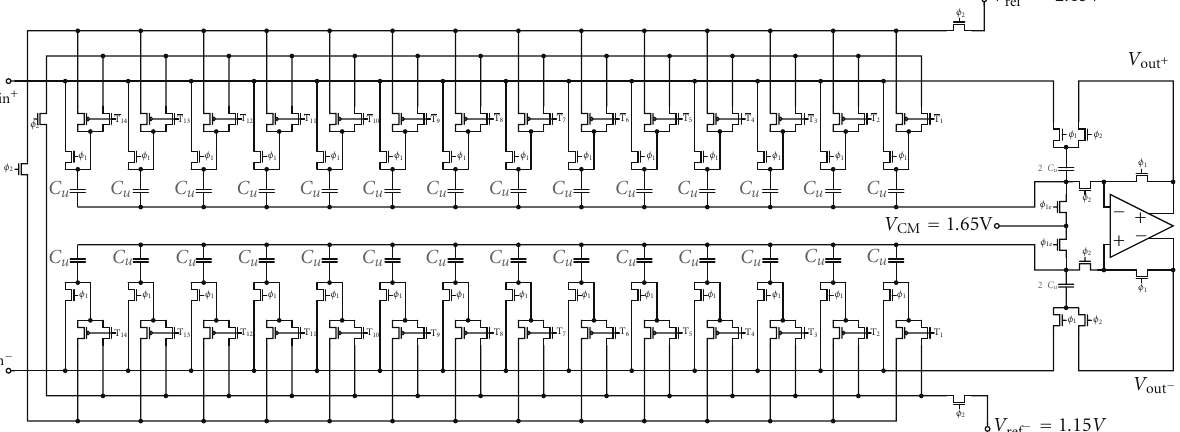
Figure 9: Multiplying DAC architecture.